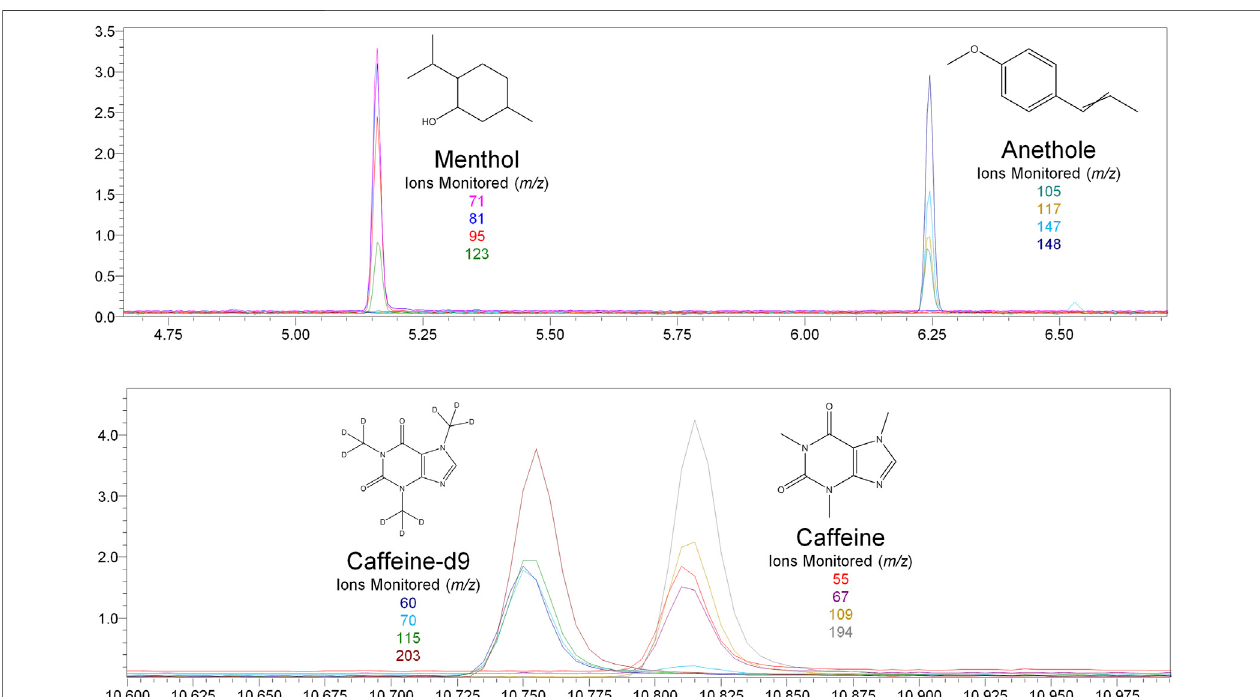
FIGURE 2 | GC-MS chromatogram produced from mixed menthol and caffeine standard (S5 – 2000 ng/ml), with structures and ions monitored for menthol, anethole, caffeine, and caffeine-d9.